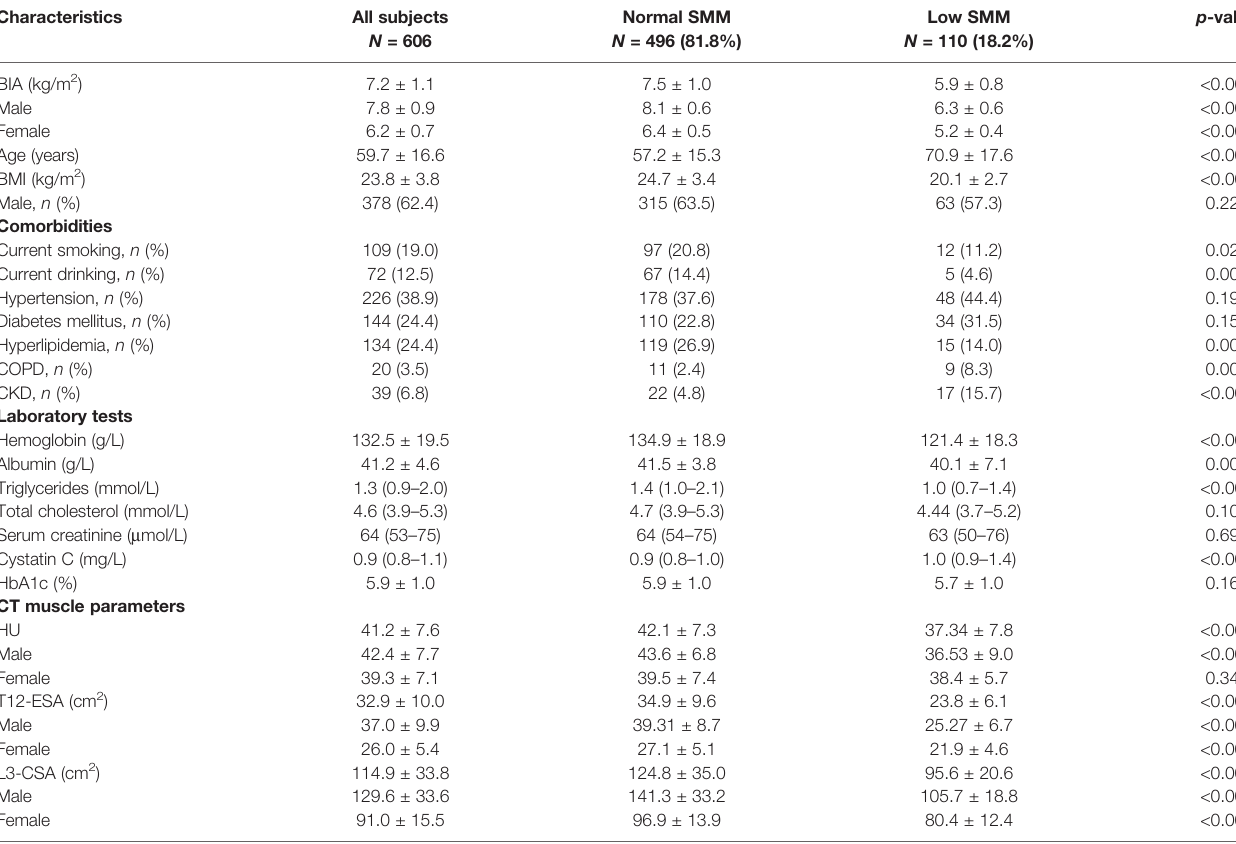
TABLE 1 | Comparison of baseline characteristics and CT muscle parameters in the study population with low SMM and normal SMM .